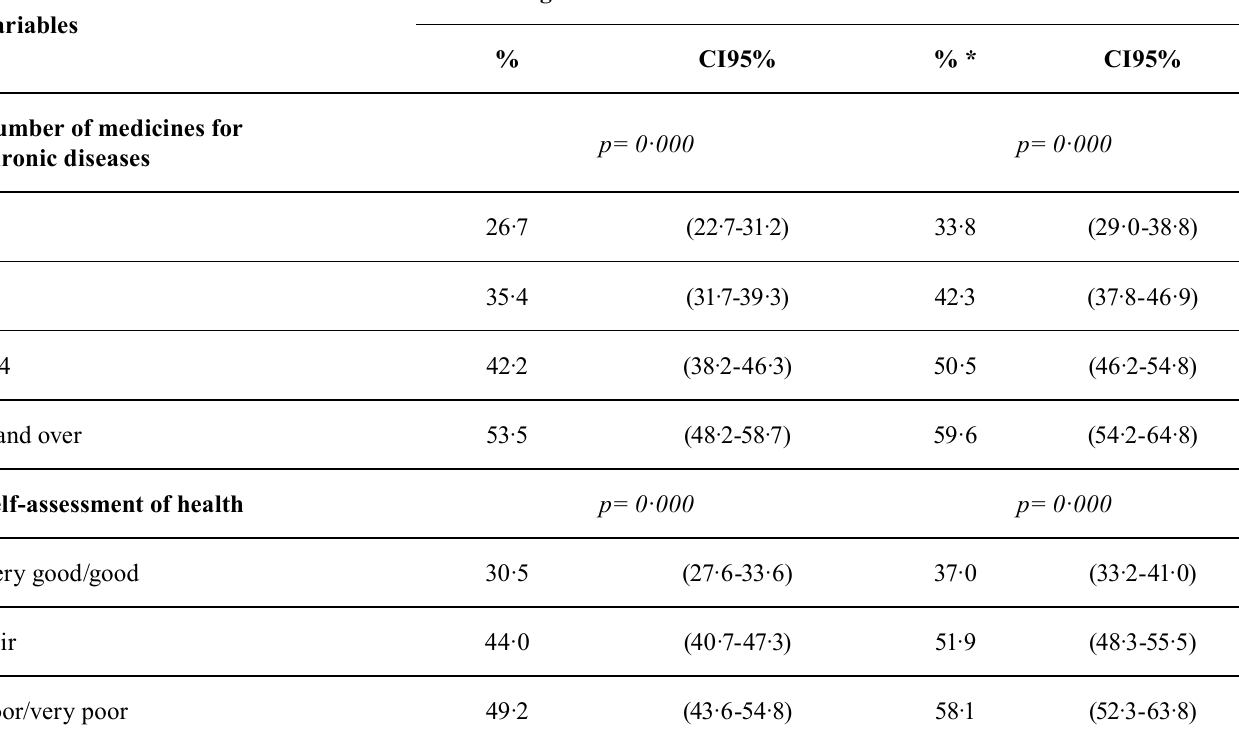
TABLE III – Difficulties of availability of medicines in SUS pharmacy services among adult and elderly (20 years and over) users of the Unified Health System (SUS) with a reported chronic non-communicable disease (NCD), indication of medicine treatment and that obtain some of the medicines in use in the SUS, according to demographic, socioeconomic and health variables. PNAUM, 2014 (N=5,155)